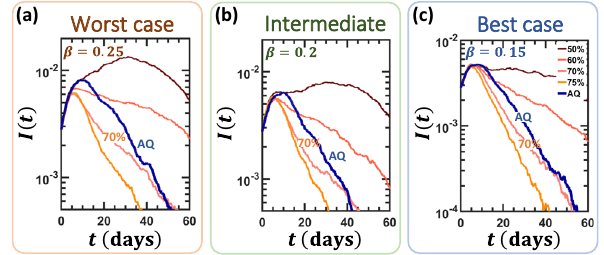
Fig. 6 Alternating quarantine vs. population-wide quarantine. a Infection level I ( t ) vs. t as obtained for β = 0.25 under Alternating quarantine (AQ, blue). We also examined population-wide quarantines at η = 50, 60, 70, and 75% levels (red to yellow). Despite having half of the population active at all times, AQ ’ s mitigation is comparable to that of a 70% population- wide quarantine. Hence, instead of an extremely hurtful socioeconomic shutdown of 70%, nearing the practical upper bound of social distancing policies, AQ offers a similar outcome under a signi fi cantly reduced socioeconomic price-tag. b , c Similar results are observed also under our intermediate ( β = 0.2) and best case ( β = 0.15) scenarios. Simulations represent an average of over 20 stochastic realizations on a network comprising 4000 households (~10 4 individuals). The in-house infection rate was set to the medium level α ≈ 0.15. Here, A ij is an Erd ő s – Rényi random graph with 〈 k 〉 = 15, similar results under a scale-free A ij appear in Supplementary Note